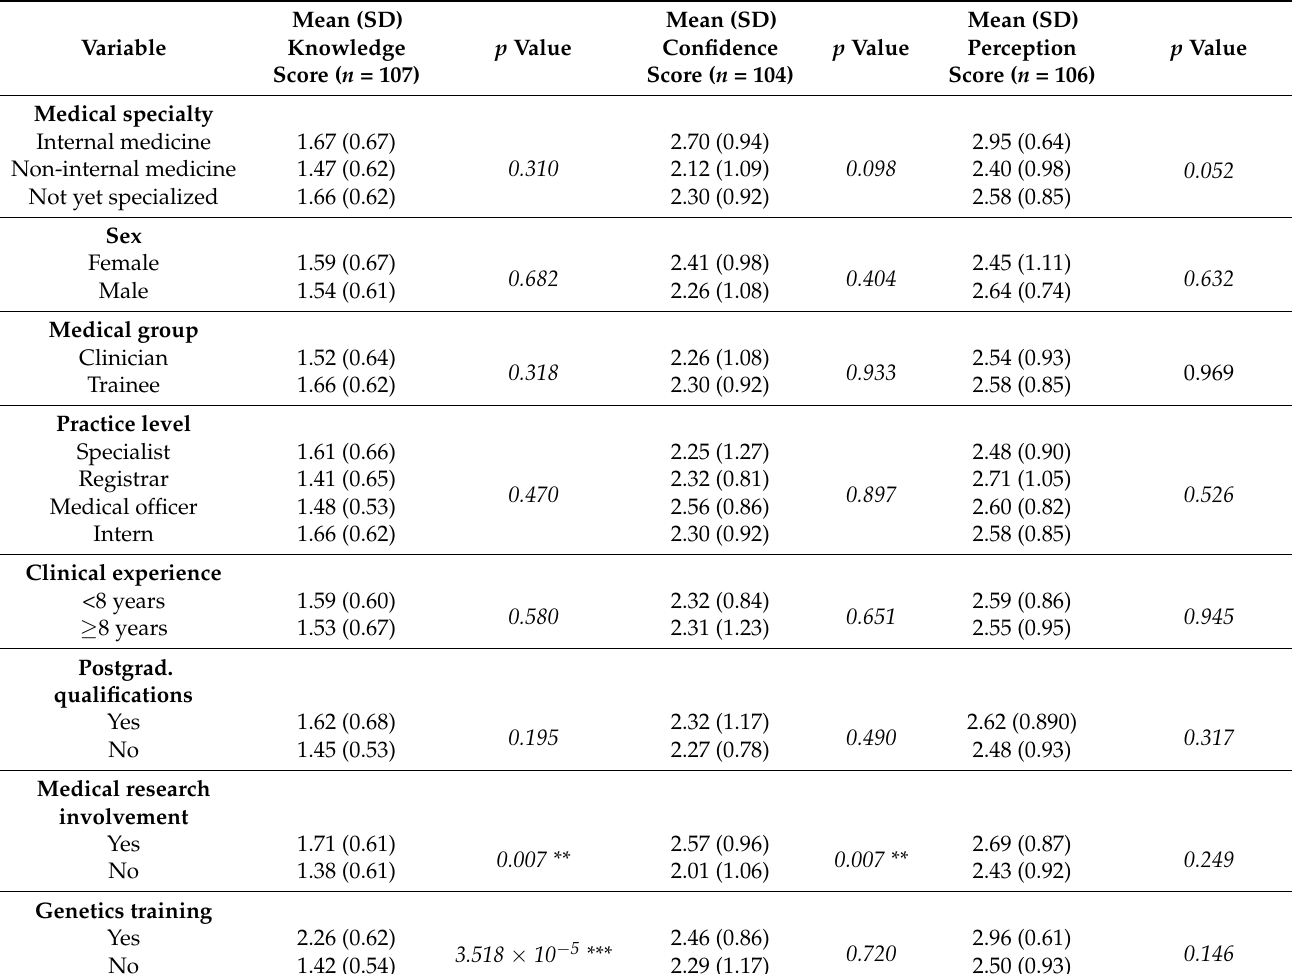
Table 4. Predictors’ influence on respondents’ mean (SD) knowledge, confidence, and perception scores. p value is assessing differences in mean scores across variable